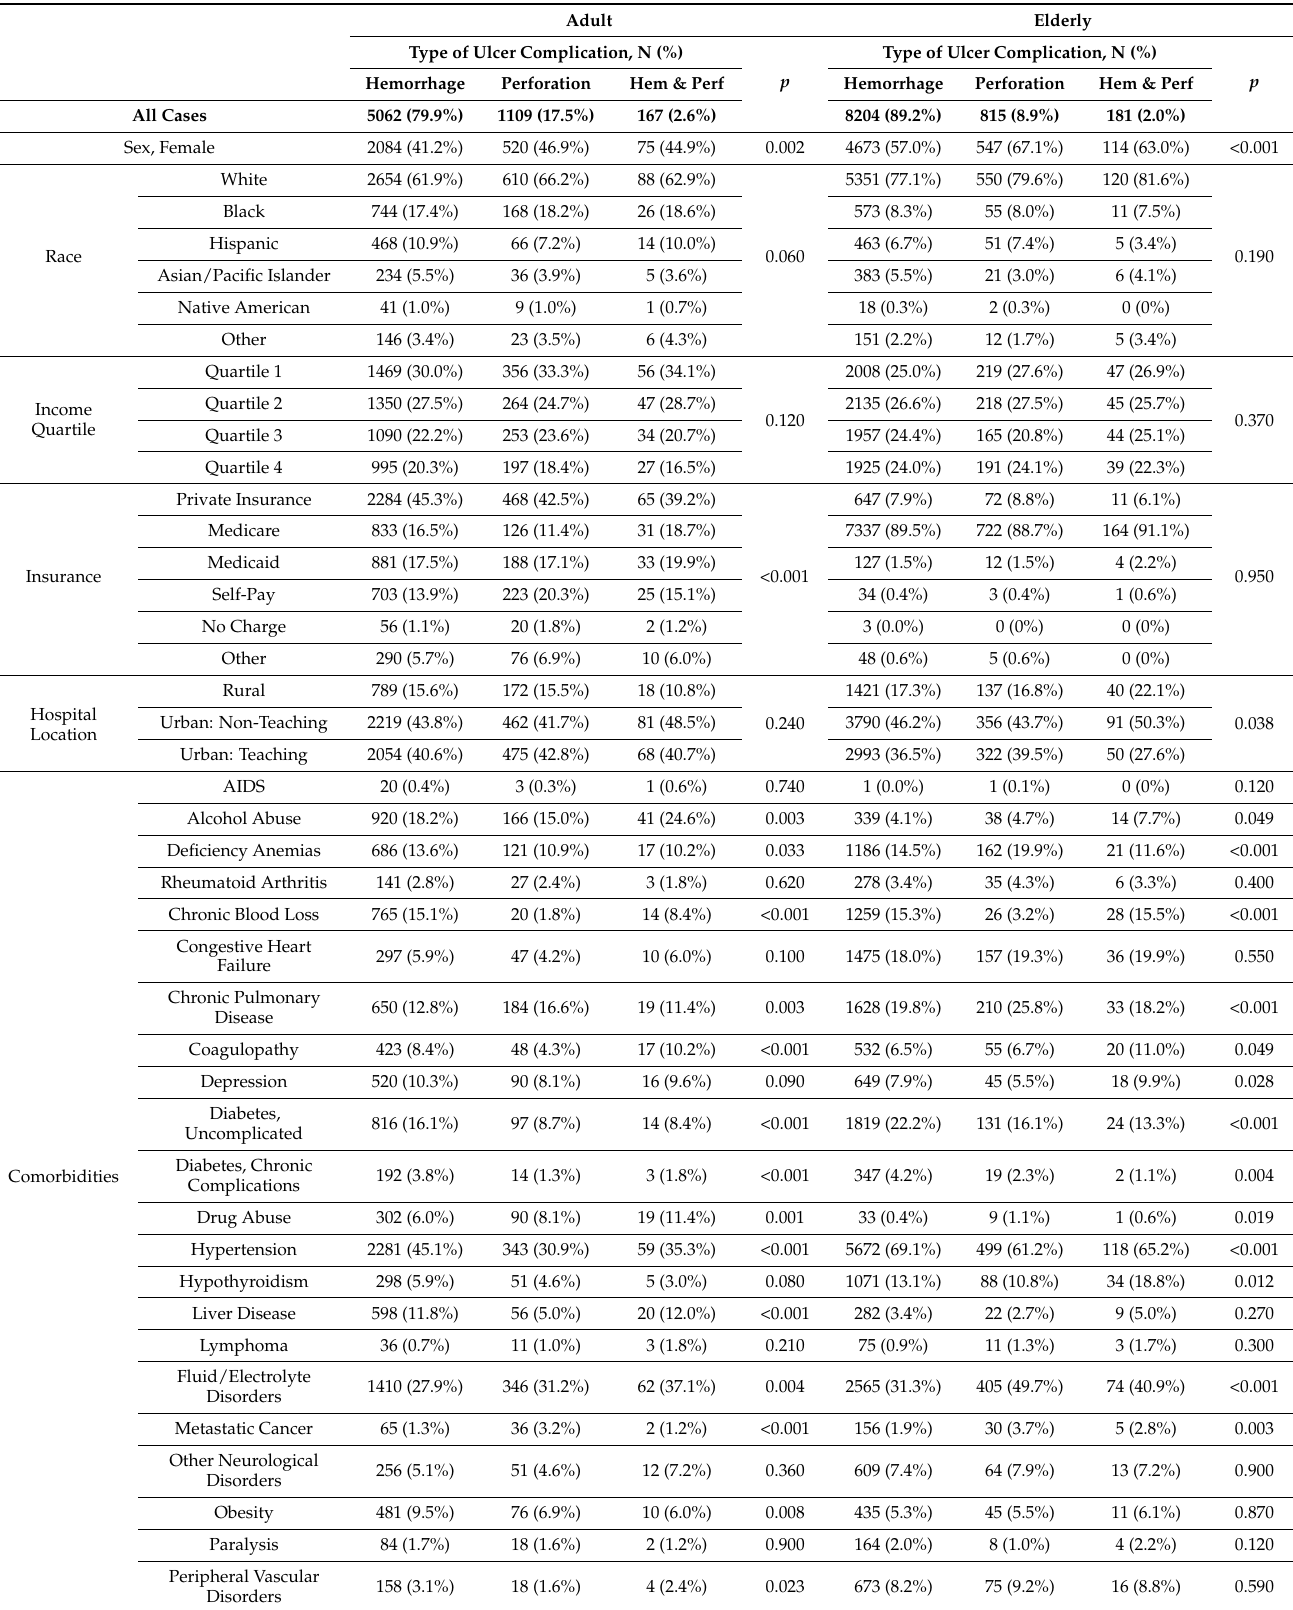
Table 4. The data presented in this table display the stratification of all emergently admitted gastric ulcer patients based on ulcer type. These data were supplied by NIS